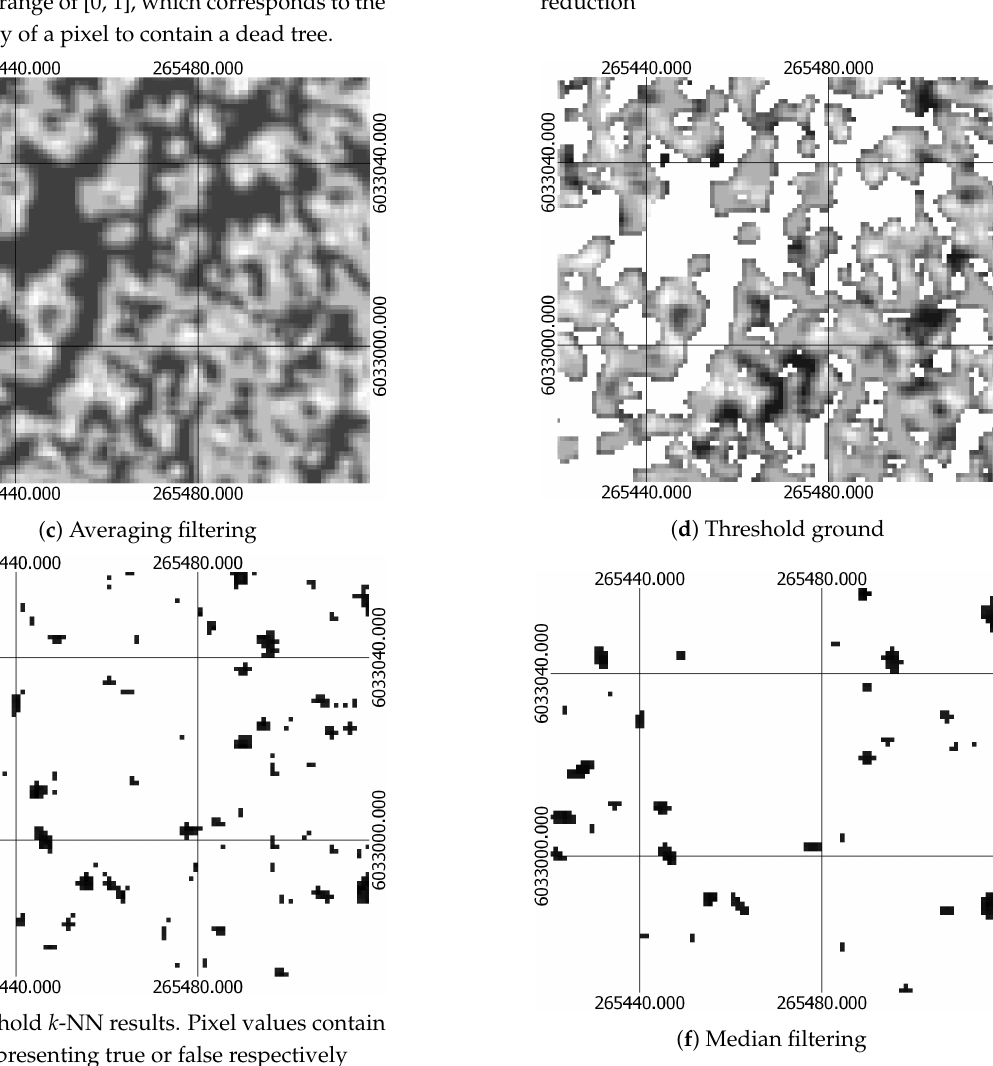
Figure 10. Processing pipeline: ( a ) contains the results of the k -NN algorithm or the fused image, ( b ) the result of applying Median filtering on the previous image, ( c ) result of applying an averaging filter on the previous image, ( d ) result once the ground is thresholded, ( e ) results once the k -NN threshold is applied ( f ) Median